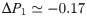
An example of long–range positive epistasis with ϵ = 0.25.Individual mutations, W4 (blue) → S4 (yellow) and G10 (green) → V10 (blue) are slightly deleterious, with ΔP1≃−0.17 and ΔP2≃−0.11 respectively (ΔP12≃−0.04). W4 is ordered (G10 is disordered) in the initial ensemble, and V10 is ordered (S4 is disordered) in the double mutant ensemble. In the double mutant, V10 occupies the nuclear site originally occupied by W4. The distance between mutated positions in panel (A) is R≃9 Angstroms. Folded ensembles for the initial and mutated sequences are shown in S5 Fig.